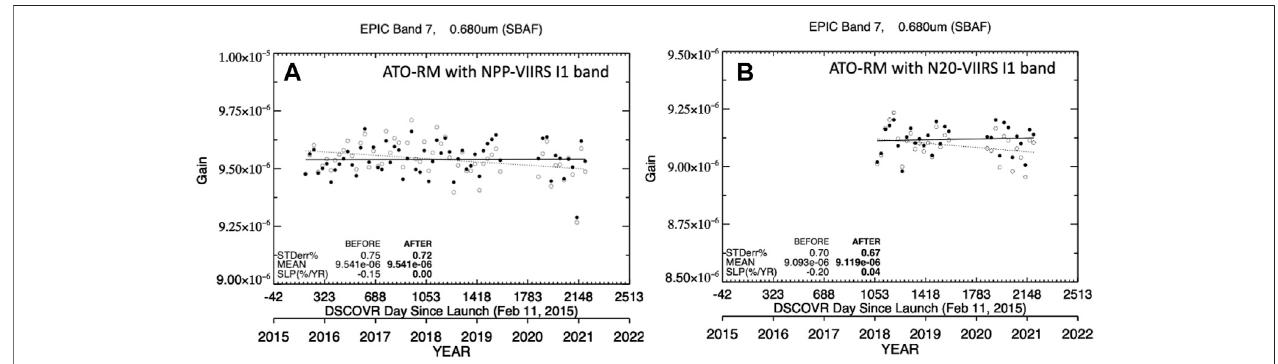
FIGURE 2 | (A) The ATO-RM E-7/V NPP -I1 monthly gains and associated linear trend line before (open circles and dotted line) and after ( fi lled circles and solid line)